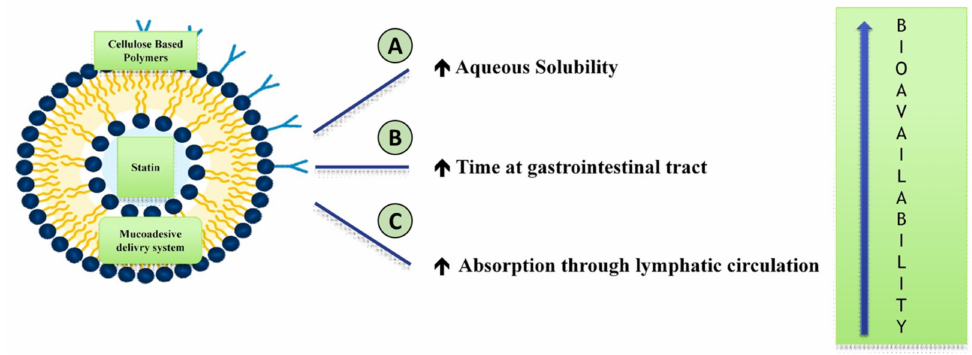
Figure 2. Structure of nanoparticles increasing the bioavailability of statins. Self-emulsifying vehicles and biodegradable inert polymers (A) (chitosan, hydroxy-propyl-merhilcellulose, polyvinylpyrroli- done, cyclodextrin) increases their aqueous solubility; mucoadhesive delivery system (B) increases the gastrointestinal transit time; cellulose-based polymers (ethylcellulose) or cellulose-free polymers (C) (polycaprolactone, polylactide-co-glycolide, polyoxypropylene and polyoxyethylene) manage to increase the affinity and absorption through the lymphatic circulation, so as to minimize the metabolism through the